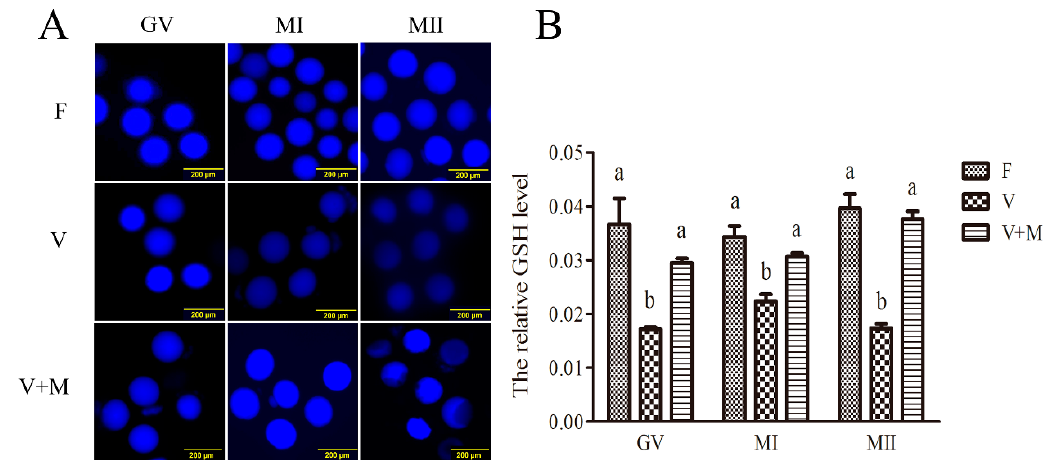
Figure 2. Effects of melatonin (MT) on GSH levels in vitrified-warmed mouse GV oocytes during in vitro maturation. ( A ): Representative fluorescence images depicting GSH levels in vitrified-warmed mouse oocytes at different stages of development (GV, MI, and MII). The oocytes were treated with CMF2 H for detection of GSH levels (blue). Fresh control (F), vitrification (V), and vitrification + MT (V + M). Scale bars = 200 µm. ( B ): Quantification of relative levels of GSH in oocytes. Fluorescence intensities of GSH levels were measured with ImageJ software. Data are presented as mean ± SEM of three independent experiments. Total number of GV oocytes used in this assay n = 352 (F: n = 116; V: n = 115; V + M: n = 121). Different superscripts (a, b, and c) indicate significant difference ( p < 0.05) between groups at the same time point (at corresponding developmental stages).